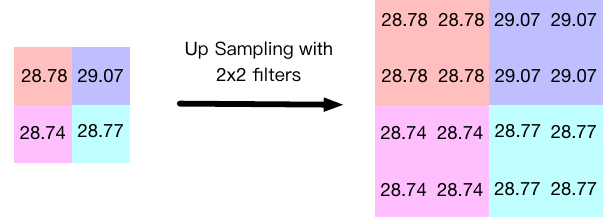
Figure 8. The upsampling that recovers the shape of the input